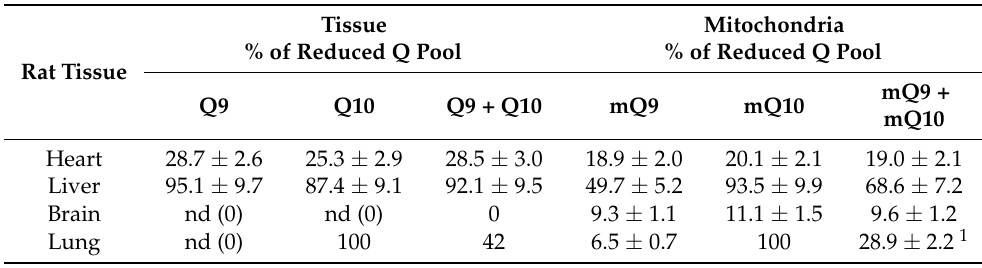
Table 2. Percentage of the reduced Q9 and Q10 pools in rat tissues and mitochondria under fully oxidizing conditions (no respiratory Q-reducing substrates).